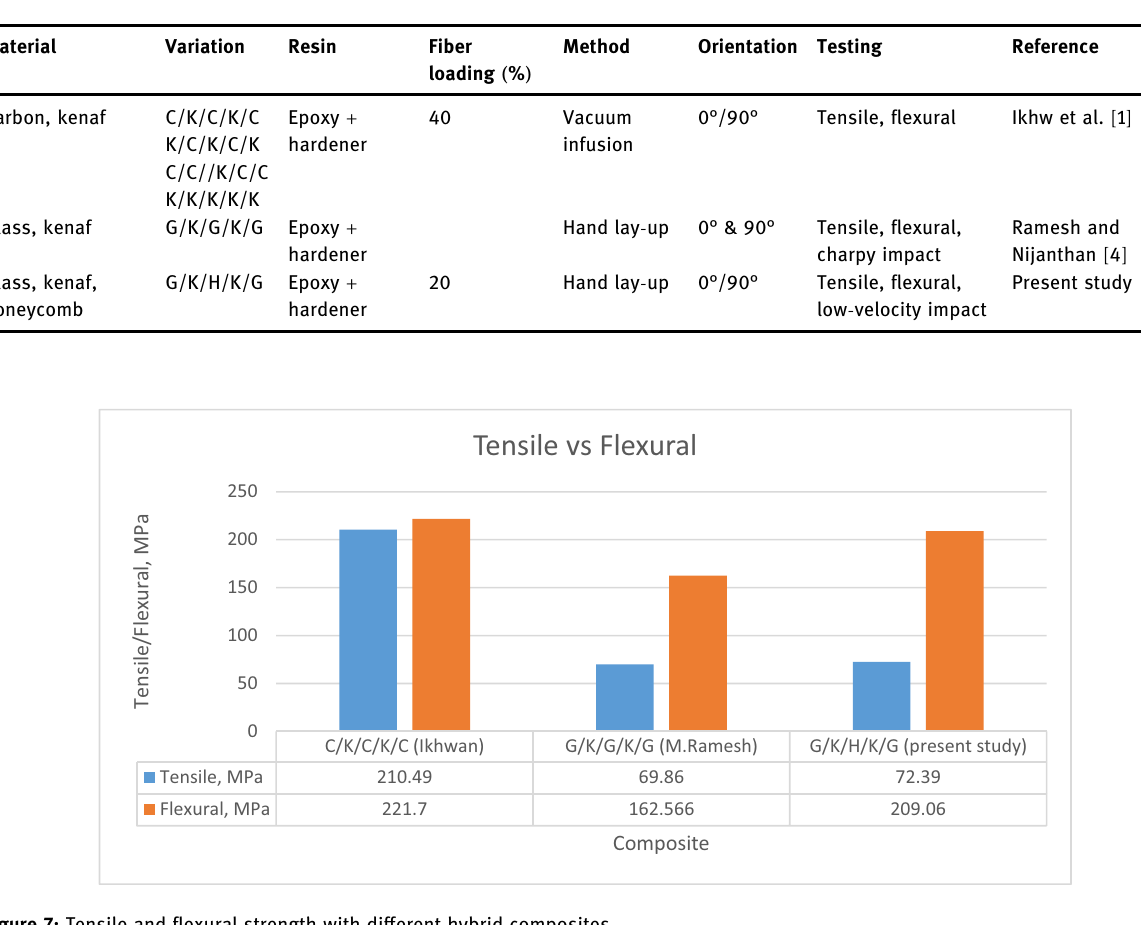
Figure 7: Tensile and fl exural strength with di ff erent hybrid